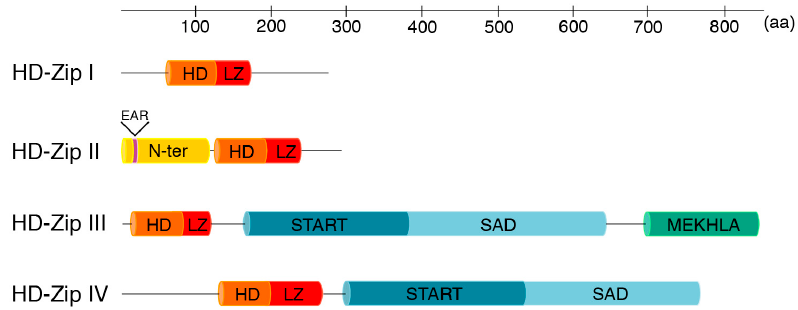
Figure 1. Schematic representation of the protein domains possessed by each HD-Zip family. ATHB1, ATHB2, ATHB8, and GLABRA2 were chosen as representative members of the HD-Zip I, II, III and IV families, respectively. N-term, N-terminus consensus; EAR, LxLxL type of ERF-associated amphiphilic repression; HD, Homeodomain; Zip, Leucine zipper; START, steroidogenic acute regulatory protein-related lipid-transfer domain; SAD, Small body size–mothers against decapentaplegic homolog 4 (Smad4) activation domain; MEKHLA, named after the identification of the highly conserved amino acids Met, Glu, Lys, His, Leu, Ala. Adapted from Ariel et al (2007) [6]. HD-Zip proteins are known to control key developmental and environmental responses